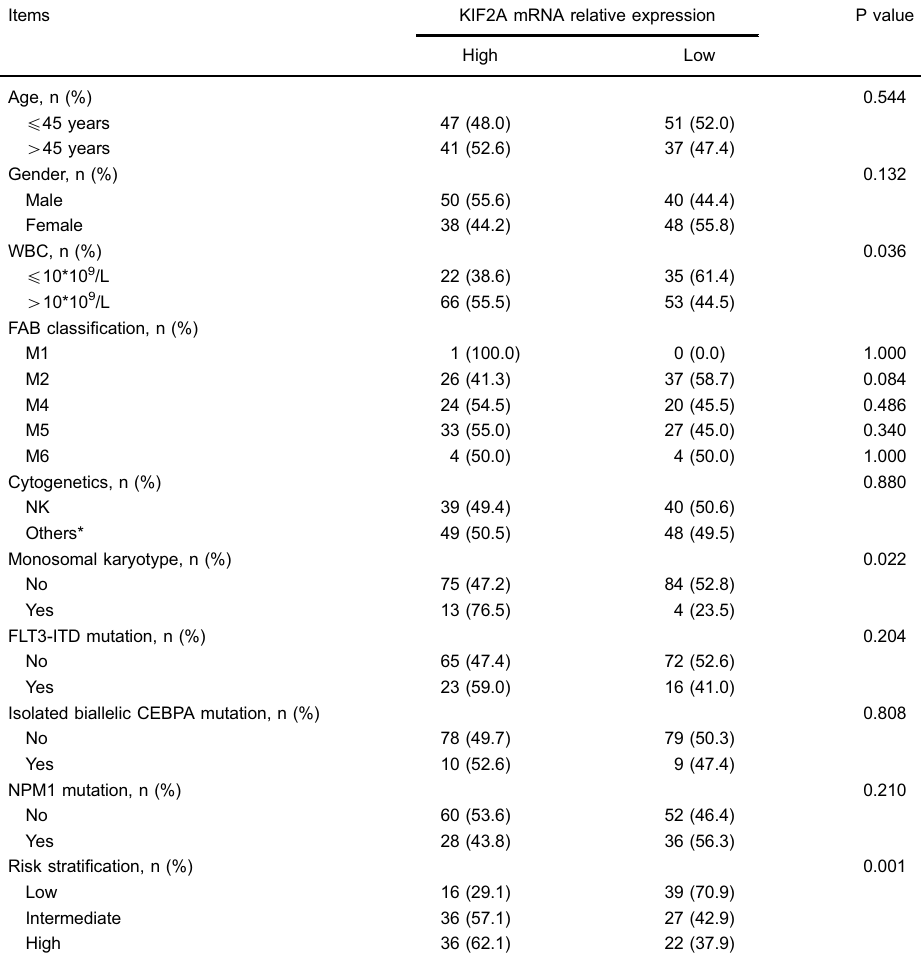
Table 2. Correlation of KIF2A mRNA relative expression with clinical characteristics. Items KIF2A mRNA relative